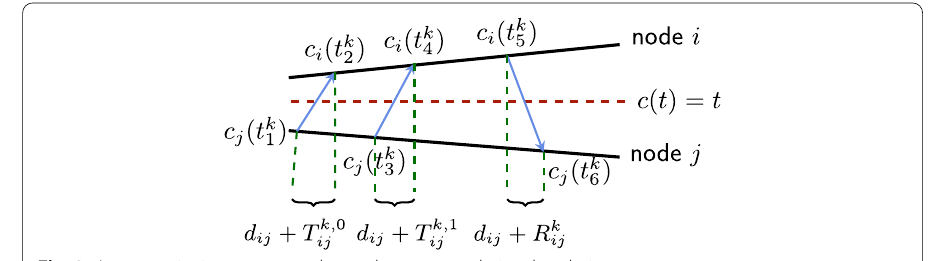
Fig. 3 Asymmetric time-stamp exchange between node i and node